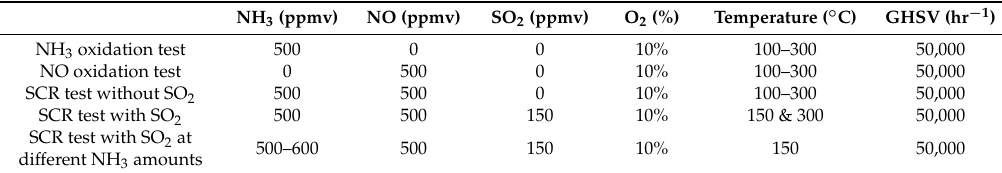
Table 3. Operation conditions of experimental tests in this